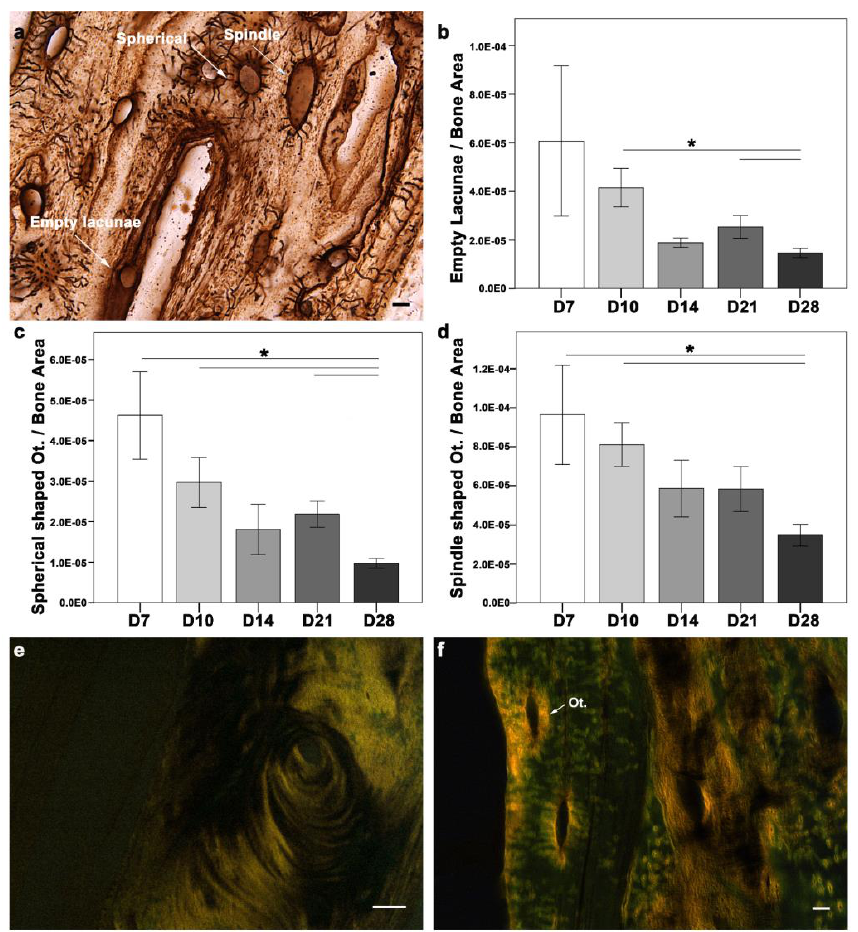
Figure 4. Histological depiction of morphological changes in osteocytes and collagen fibril arrange- ment during fracture healing in the fracture gap. ( a ) Osteocytes were present in abundance around the fractured callus at all time points (spindle: active, spherical: intermediate, empty: dead). ( b ) Empty lacunae were significantly lower at D28 when compared with D10 and D21. ( c ) Spherical- shaped osteocytes were significantly lower at D28 when compared with D7, D10, and D21. ( d ) Spin- dle-shaped osteocytes were significantly lower at D28 when compared with D7 and D10. ( e ) Well- arranged collagen fibers seen around the fractured callus (bright yellowish areas) ( f ) Type I collagen ring-like structure seen around the osteocytes (bright yellowish areas); positive stained regions were located within the ossified region at the periosteal surface of the callus tissue at D7. (N: D7 = 4, D10 = 6, D14 = 3, D21, D28 = 5); non-parametric distribution, Mann-Whitney U-test, * = p ≤ 0.05, Ot: oste- ocyte, scale bar: ( a ) (5 µm), ( e ) (25 µm), ( f ) (5 µm)). Type I collagen fibers were seen in the soft callus and around the cortices at D7, cor- responding with the early ossification phase. Type I collagen at D10 was observed in the periosteal region, corresponding to intramembranous ossification. Type I collagen distri- bution changed with the healing progression. A different orientation of fibrils was seen at D14, with progression toward endochondral ossification and hard callus formation. Well- aligned and longer collagen fibers were seen in both the endosteum and periosteum re- gions at D21 and D28. The collagen fibers were seen in the fractured callus region at all time points (Figure 4e). Intriguingly, type I collagen rings were seen around the osteocytes at all time points (Figure 4f).